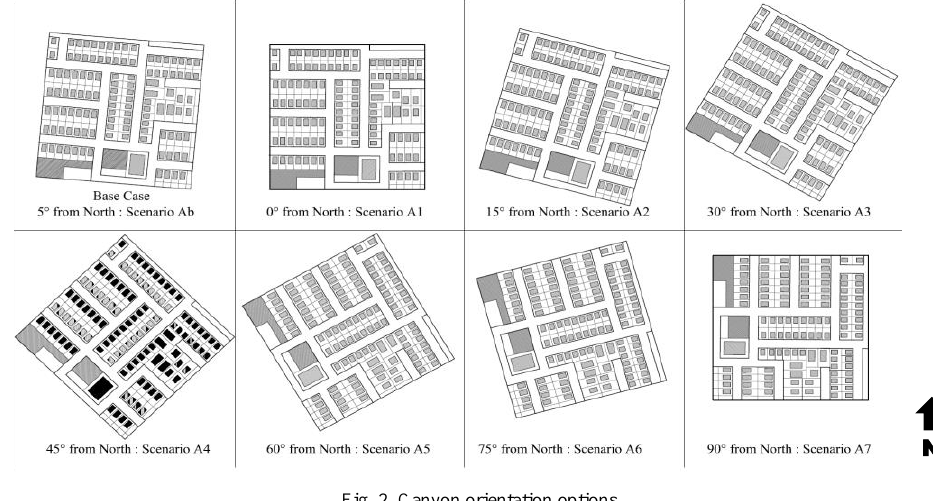
Fig. 2. Canyon orientation